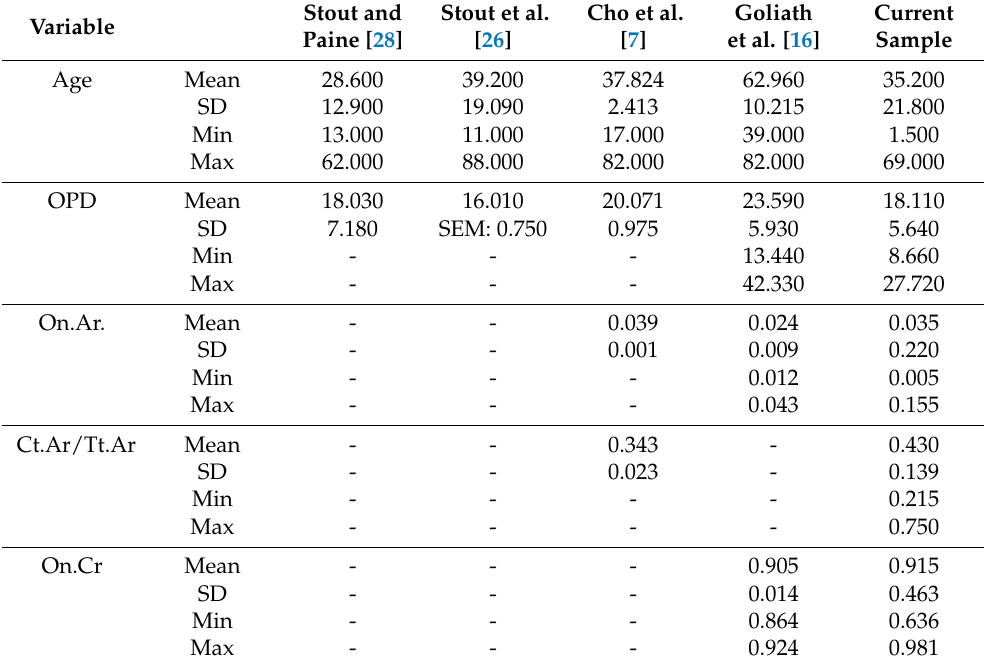
Table 4. Descriptive statistics for the age and the histomorphometric variables of the current and reference rib samples.